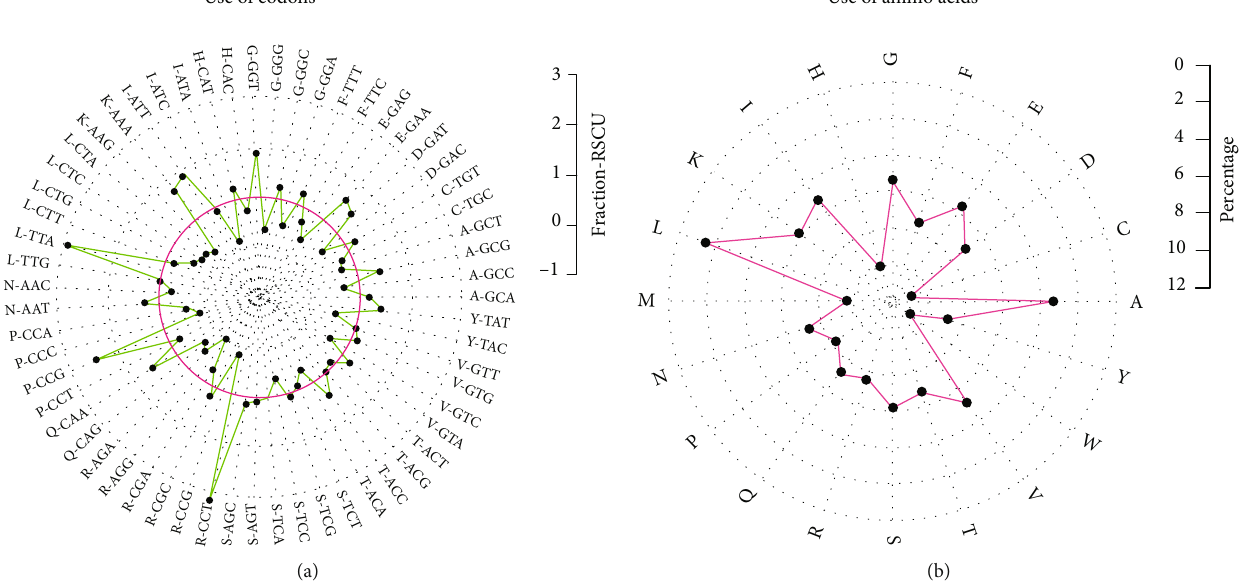
Figure 2: Use of codons and their respective amino acids of A. pleuropneumoniae . (a) The trend in the use of codons is represented in the circular map. Methionine, tryptophan, and stop codons were omitted. Synonymous codons for an amino acid used with equal frequency have RSCU = 1 , indicated by the red circular line. (b) Percentage of the use of amino acids represented in the circular map. A: alanine; C: cysteine; D: aspartic acid; E: glutamic acid; F: phenylalanine; G: glycine; H: histidine; I: isoleucine; K: lysine; L: leucine; M: methionine; N: asparagine; P: proline; Q: glutamine; R: arginine; S: serine; T: threonine; V: valine; W: tryptophan; Y: